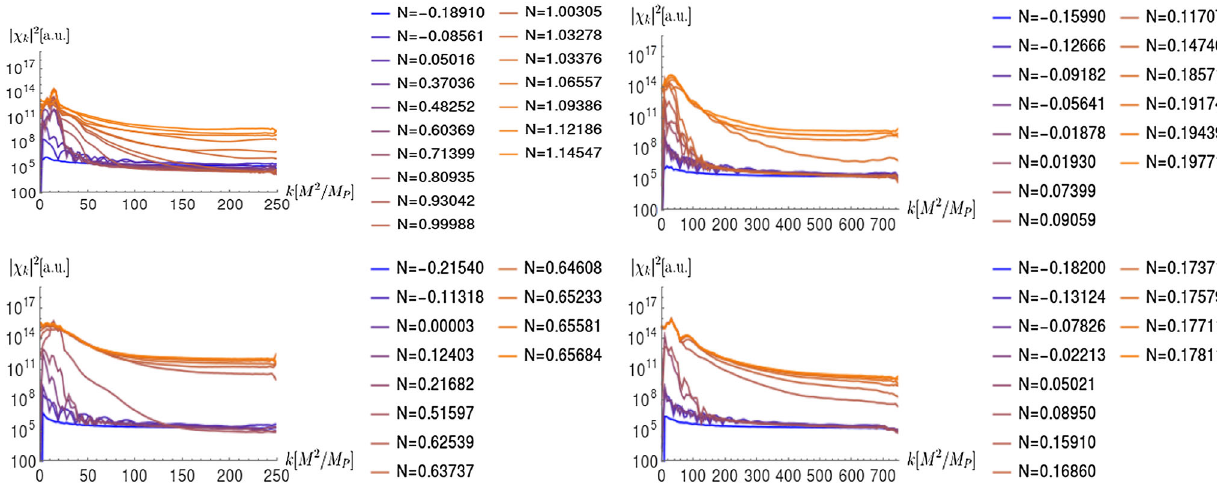
Fig. 8 The power spectrum of the spectator perturbations for n = 1 ,α = 10 − 3 (upper left), n = 1 ,α = 10 − 4 (upper right), n = 1 . 5 ,α = 10 − 3 (lower left), n = 1 . 5 ,α = 10 − 4 (lower right) for different number of e-folds N after the end of inflation